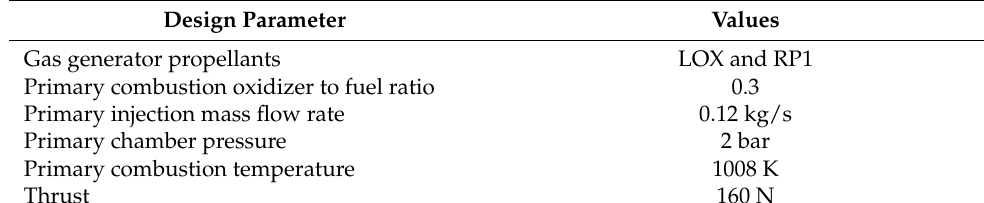
Table 2. Gas generator design parameters.